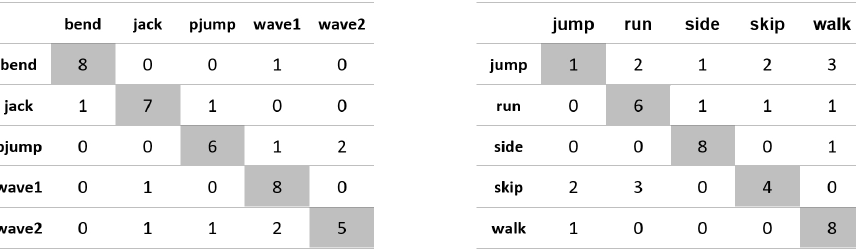
Figure A11. Confusion matrices for the experiment using the ‘lower-occlusion’ database, elongation and C1 correlation.